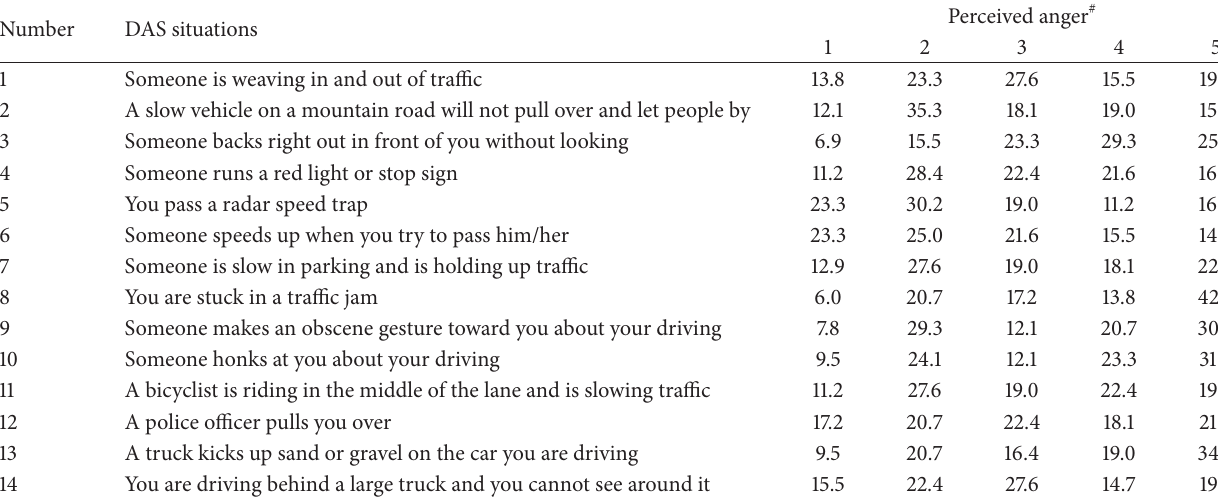
Table 2: Responses to DAS situations by study population.